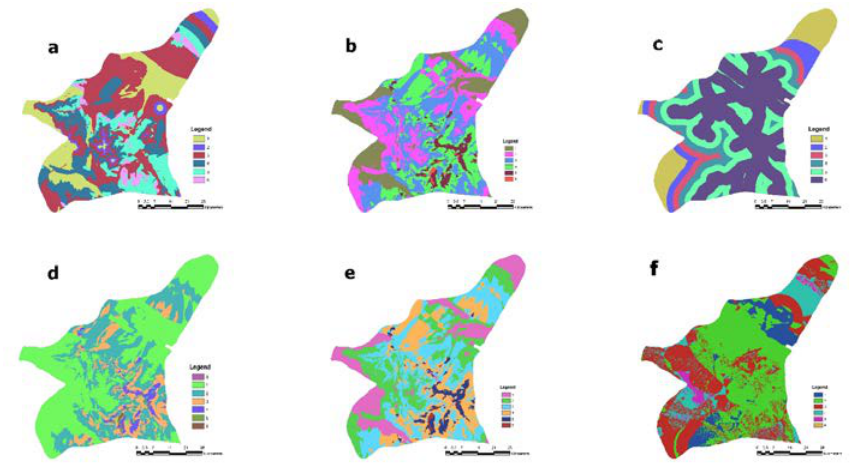
Fig 7: Classification of the gas power plant by fuzzy operator maps and classified fuzzy weighted map (WLC); a) AND; b) GAMMA; c) SUM; d) PRODUCT; e) OR; f) WLC Table 3: The suitability amount of operator